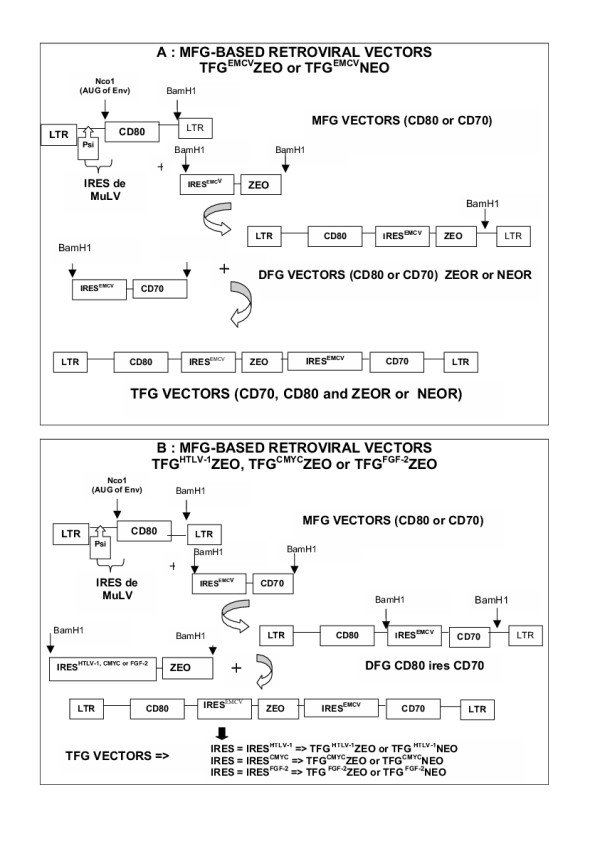
Structure of retroviral constructs. TFG vectors are MFG-based retroviral plasmids into which the hCD70 cDNA and hCD80 cDNAs have been cloned, with either a neoR or a zeoR selectable marker gene. The three genes are co-translated from a tricistronic mRNA which was transcribed from the 5' long terminal repeat. The translation of the first cDNA (CD70 or CD80) depends on the 5' long terminal repeat-gag IRES, while the translation of the selectable marker and the second cDNA (CD70 or CD80) are dependent on two IRESes from different origins.